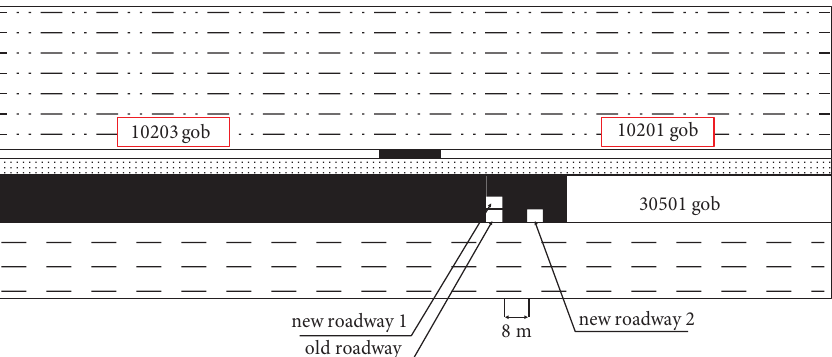
Figure 6: Calculation model of the return air roadway in the Tashan China coal